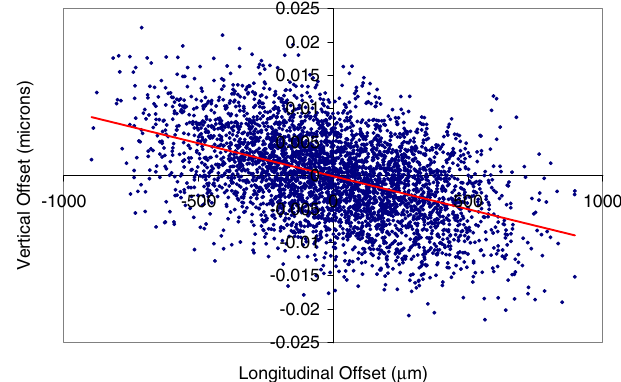
FIG. 4. (Color) The vertical offset against longitudinal position for the macroparticles in a bunch at the IP of the ILC where the crab cavity has a 10 mrad roll misalignment.